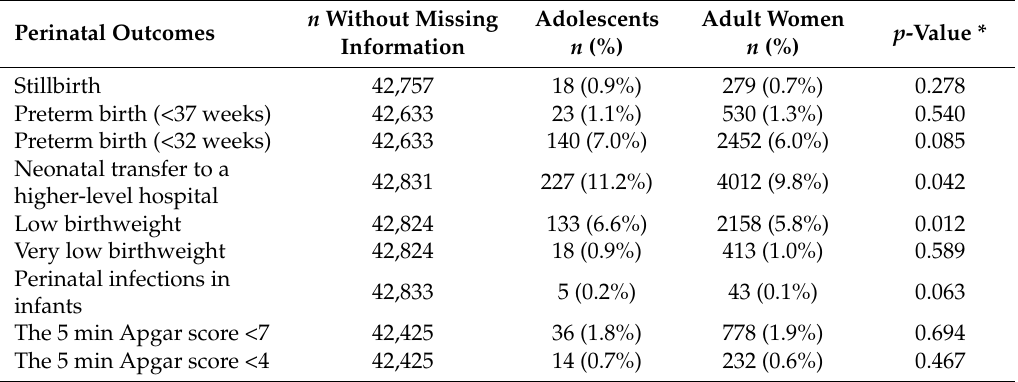
Table 2. Bivariate analyses of adverse pregnancy outcomes, according to mothers’ age, the ACBR, Russia,